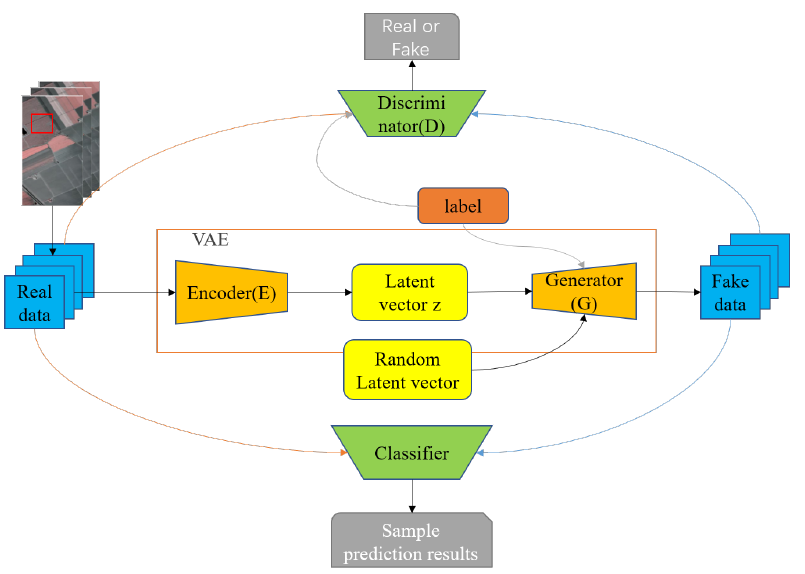
Figure 2. The structure of the proposed